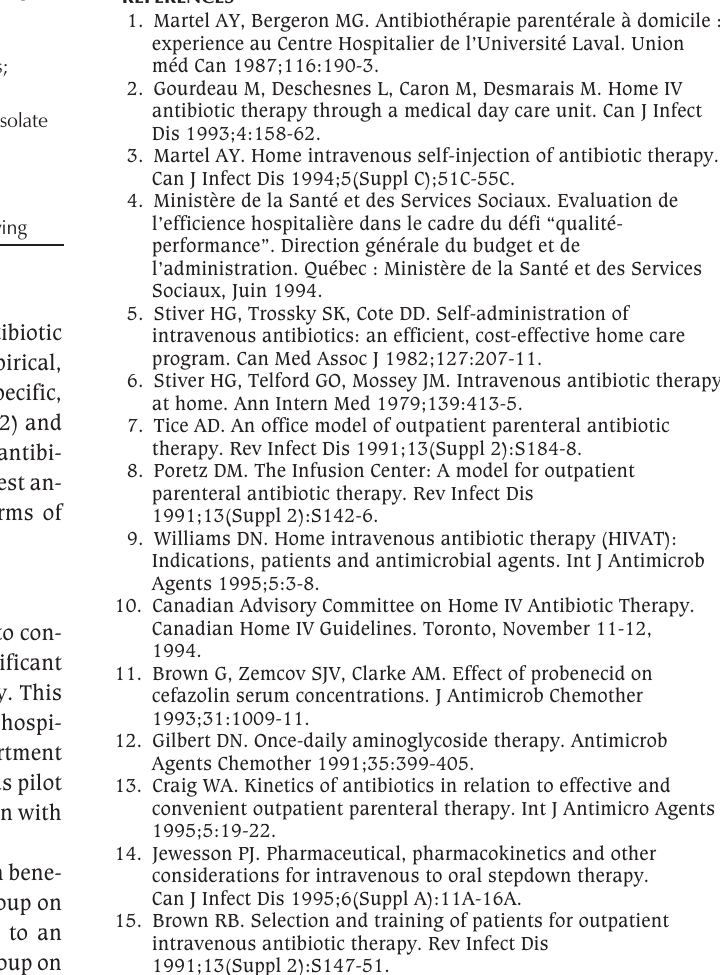
Types of patients on outpatient intravenous antibiotic therapy Short term therapy Long term therapy No other disease Multiple chronic diseases Minimal diagnosis; work up without hospitalization Skin/soft tissue infections; urinary tract infections Primary physicians; surgical/medical specialists Empirical therapy (with guidelines)